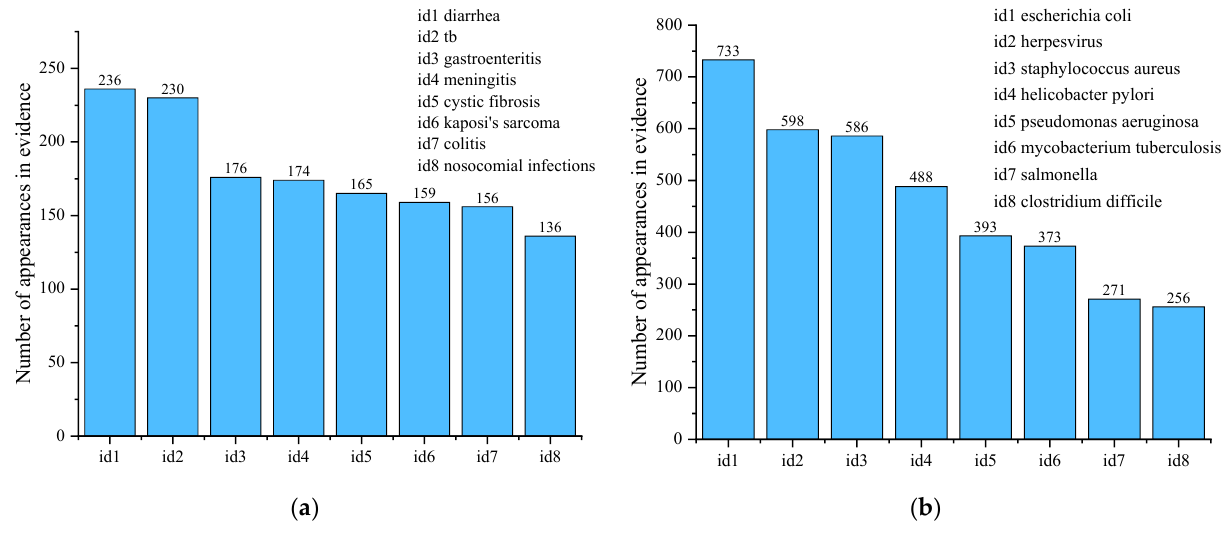
Figure 2. ( a ) Top 8 diseases with most evidence; ( b ) top 8 microbes with most evidence.